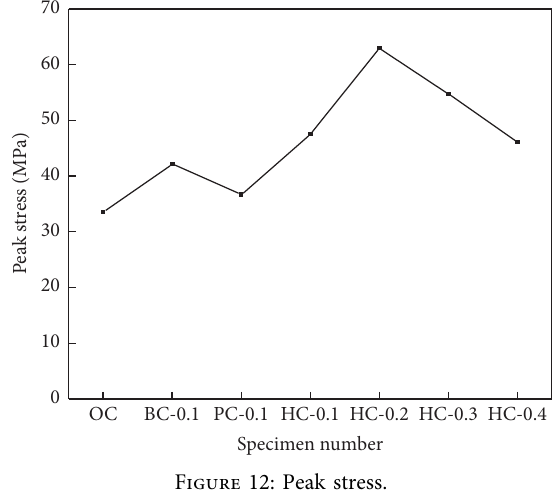
Figure 12: Peak stress.